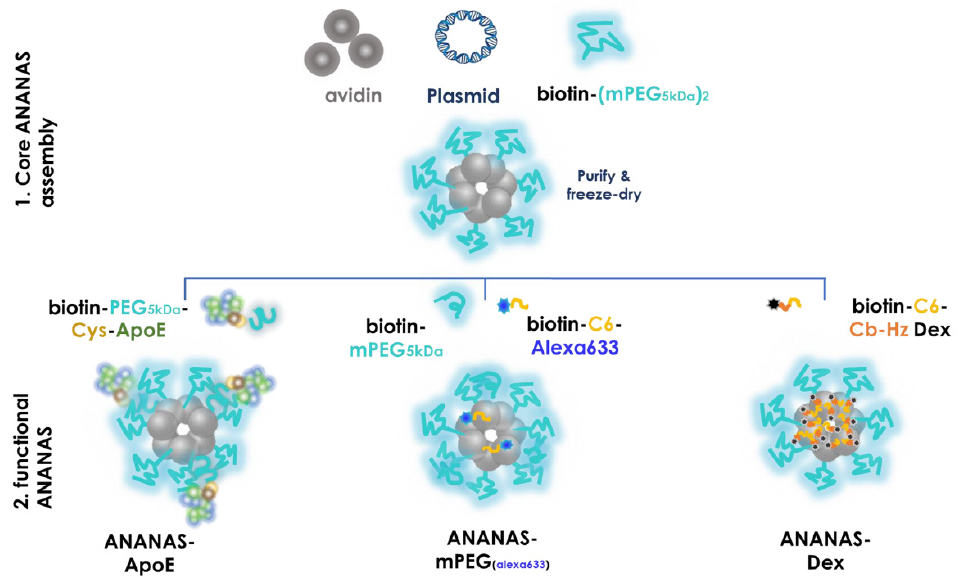
Figure 1. Schematic representation (not in scale of the formulations selected for the in vivo studies). Upper panel: components of the core ANANAS; lower panel: functional assemblies are generated by mixing core ANANAS with the different biotin components at predefined biotin:ANANAS BBS molar ratios.